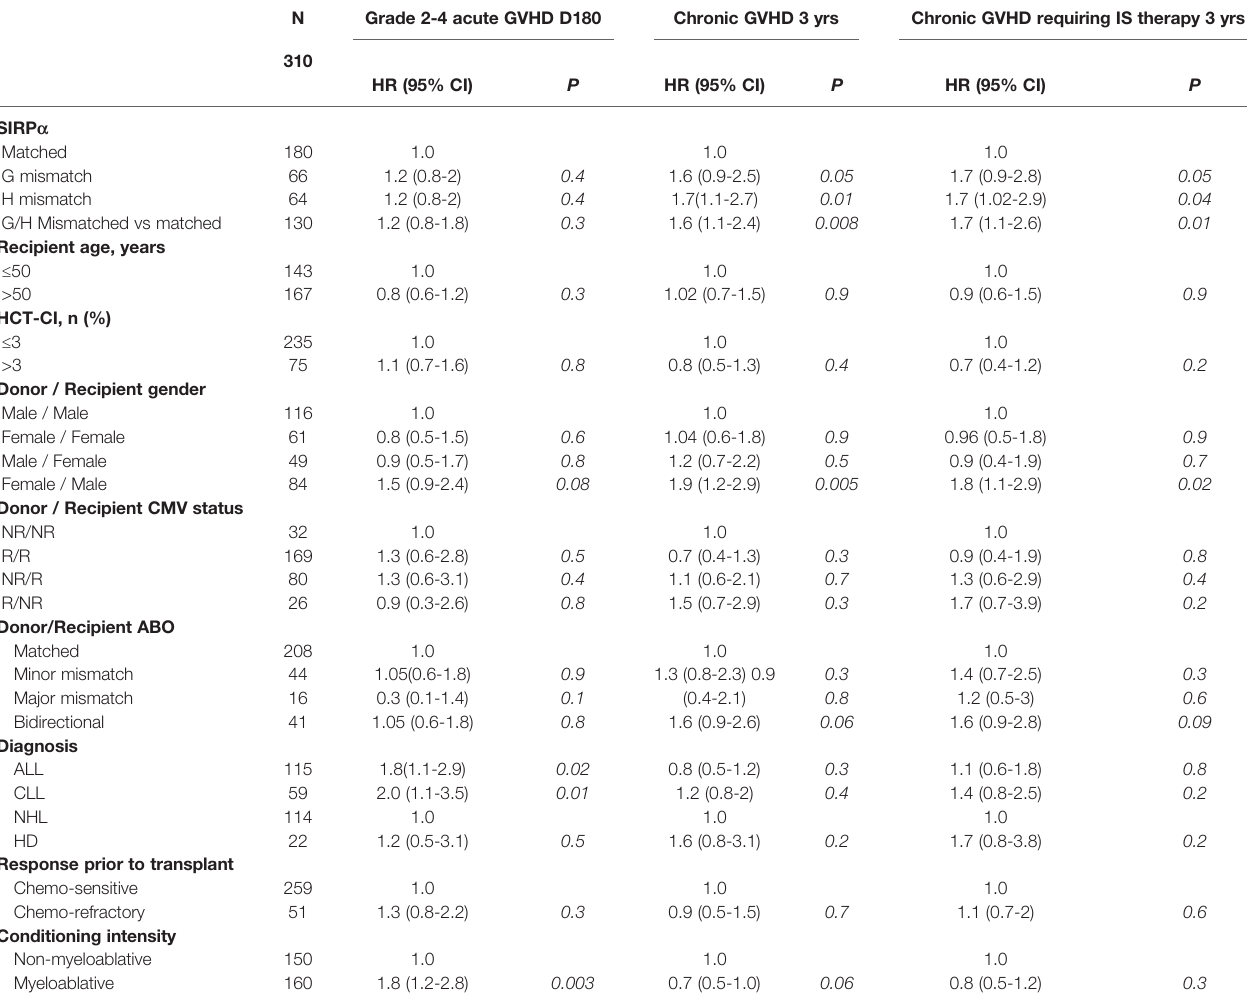
TABLE 2 | Univariable analysis evaluating predictors of grade 2-4 acute GVHD, chronic GVHD and chronic GVHD requiring immunosuppressive